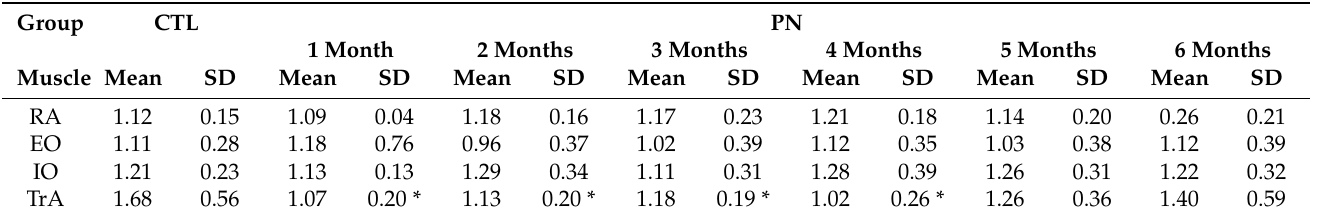
Table 3. Comparison of abdominal muscle thickness ratio between perinatal and control groups. Group